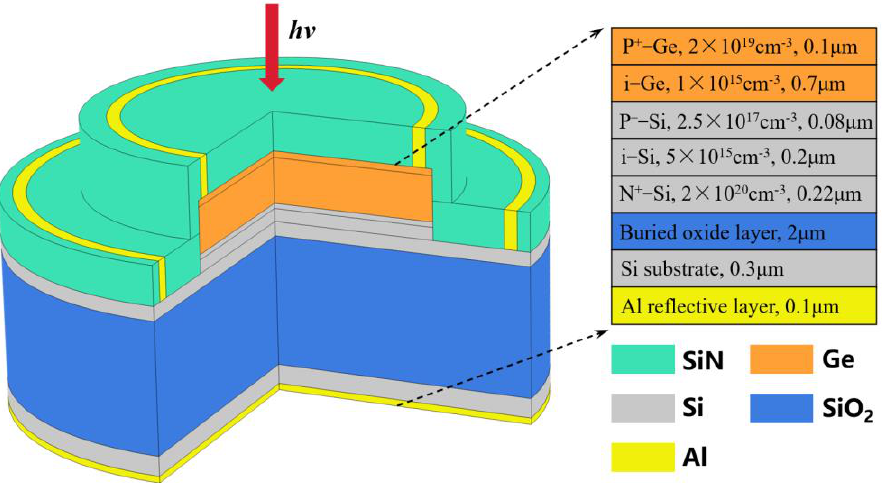
Figure 4. 3D schematic of the surface-illuminated SACM Ge/Si APD.